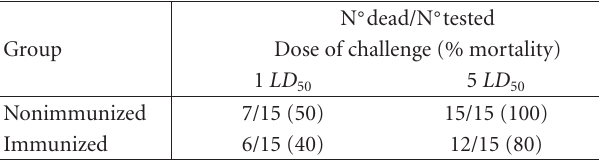
Table 2: Mortality ratio (number dead/number tested) of mice im- munized with scorpion venom. Groups of mice were weekly sub- cutaneously immunized with 0 . 5 LD 50 of CSV. One week after the third injection the animals were intraperitoneally challenged with 1 or 5 LD 50 of CSV per animal. Nonimmunized mice were challenged with 1 or 5 LD 50 per animal. The mortality was recorded at 24, 48, and